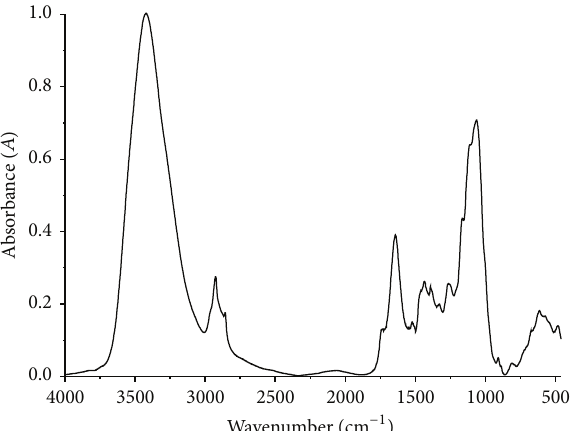
Figure 5: FT-IR spectrum of sample S1 sample of giant reed obtained with the KBr transmission technique.